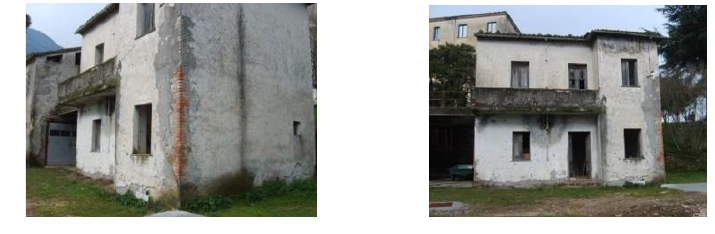
Figure 3. House next to the convent (from which the old-2 bricks were